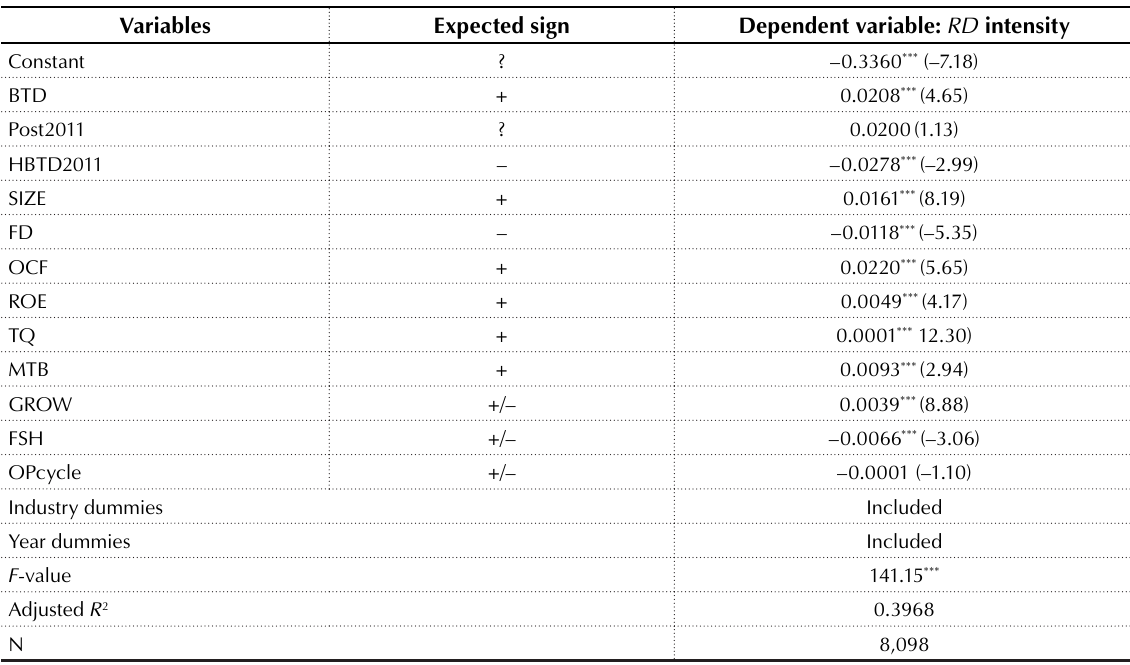
Table 6. Regression results for R&D